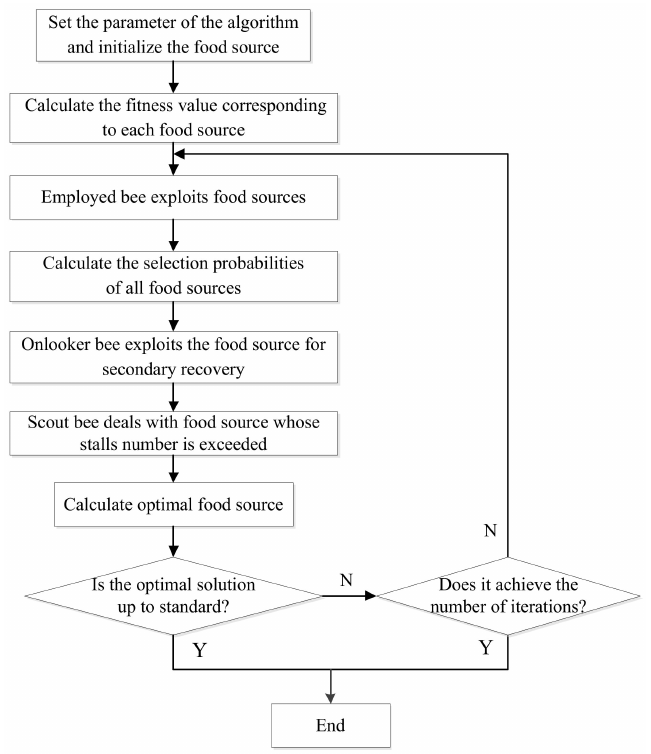
Figure 1. The flowchart of the basic ABC